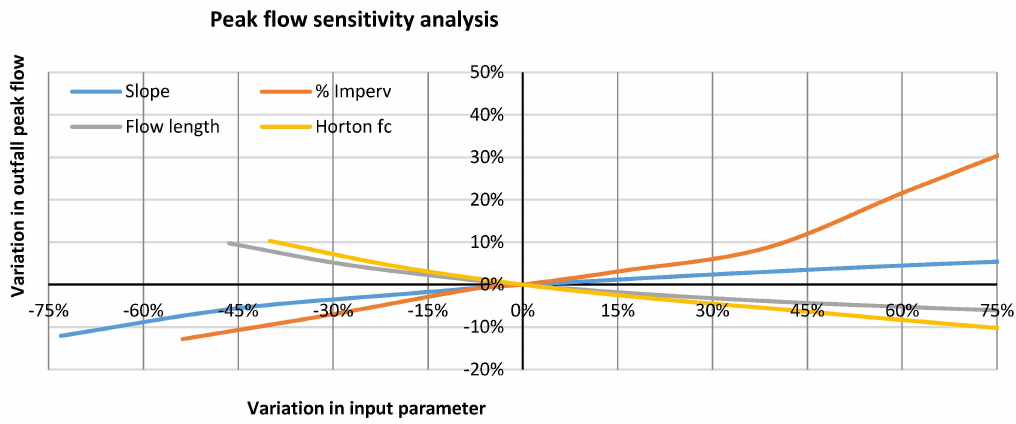
Figure 3. Peak flow sensitivity